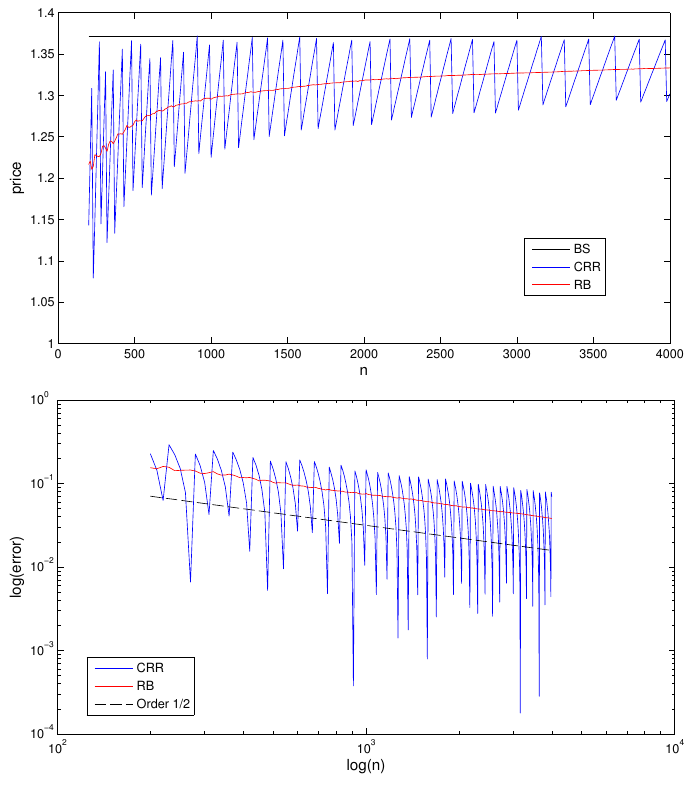
Figure 5. CRR vs. RB: up-and-in barrier put, T = 1, r = 0.1, σ = 0.25, s 0 = 100, K = 110, B = 120.